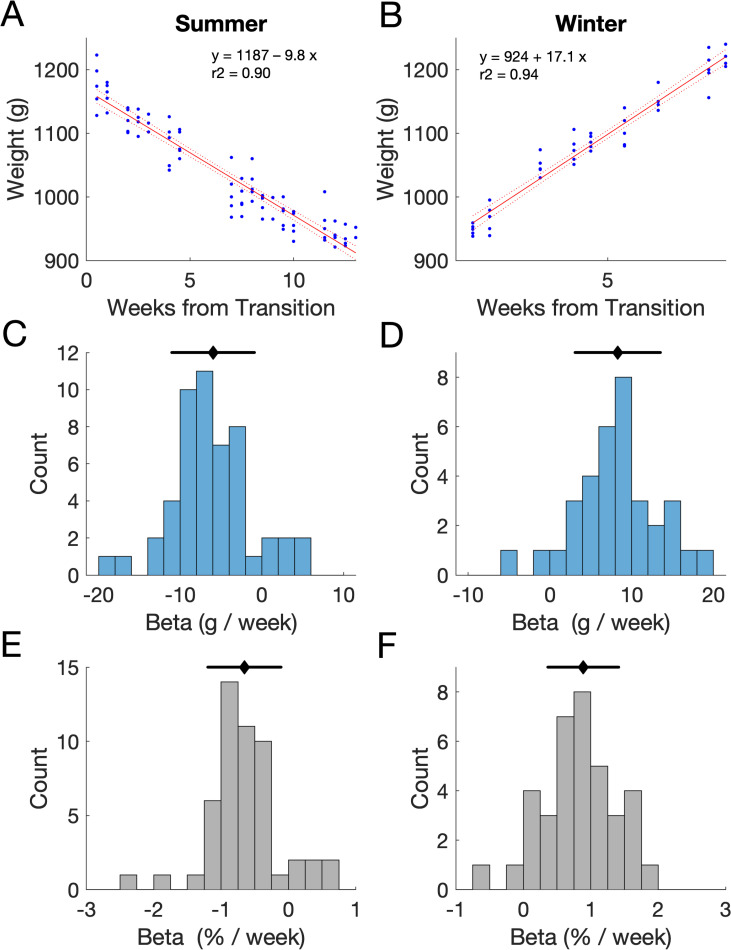
Seasonal weight changes.A-B Representative data from one animal (F1606) during summer 2018 (A) and winter 2017/18 (B). Symbols indicate individual weight measurements; plotted according to the number of weeks since the transition to summer light cycles. Line indicates the regression fit (and confidence bounds). Regression coefficients, Summer: β = -9.84 g/week or -0.94% per week (t = -26.8, p<0.001); Winter: β = 17.01 g/week or 1.66% per week (t = 27.8, p<0.001). C-D Regression coefficients for all unique animal-transition combinations between 2017–2019 during summer (C, n = 51 ferret x transition combinations, 33 unique animals) and winter (D, n = 37 ferret x transition combinations, 28 unique animals). Black lines indicate the mean and standard deviation. E-F Regression coefficients from C-D expressed as a percentage of long-term mean body weight.